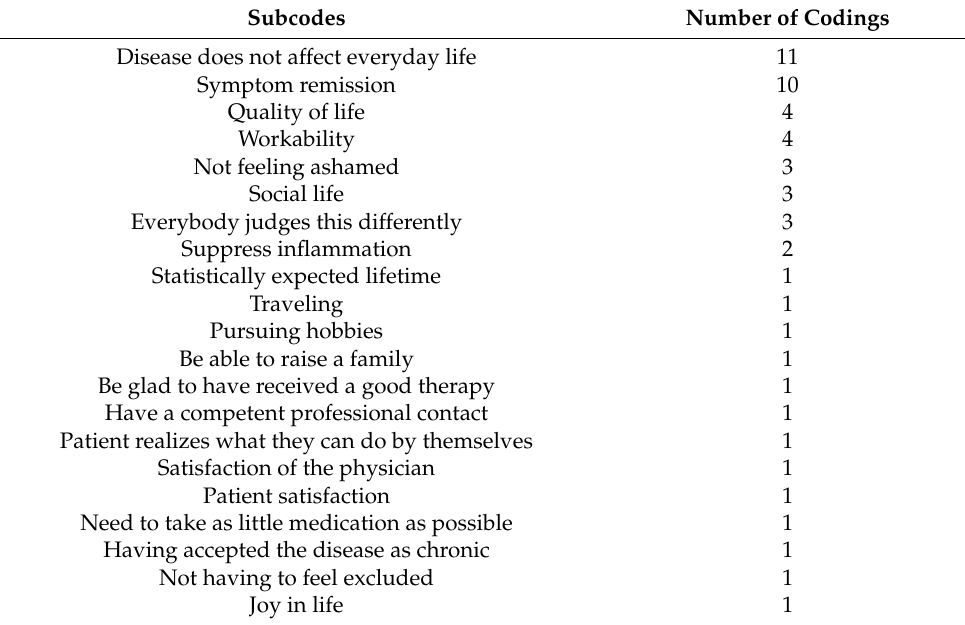
Table 5. What is a Good Life with